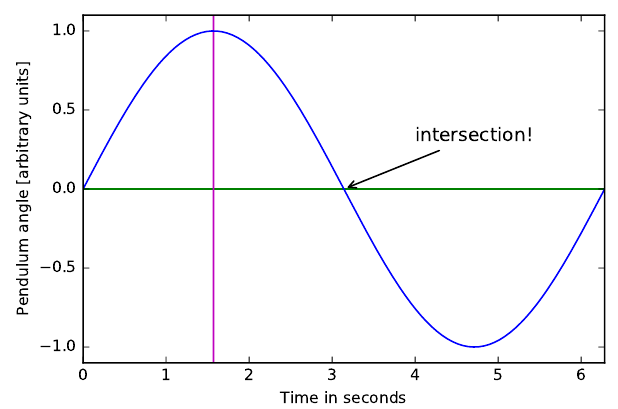
Fig. 86.— Sine curve, with vertical and horizontal lines, and annotated has added an annotation. The string argument is the text to be displayed. The xy tuple specifies the coordinate point for where the arrow points, the xytuple where the annotation text should be displayed. The fontsize option gives the size of the font used, in points; you can add this option to pretty much any function which displays text.